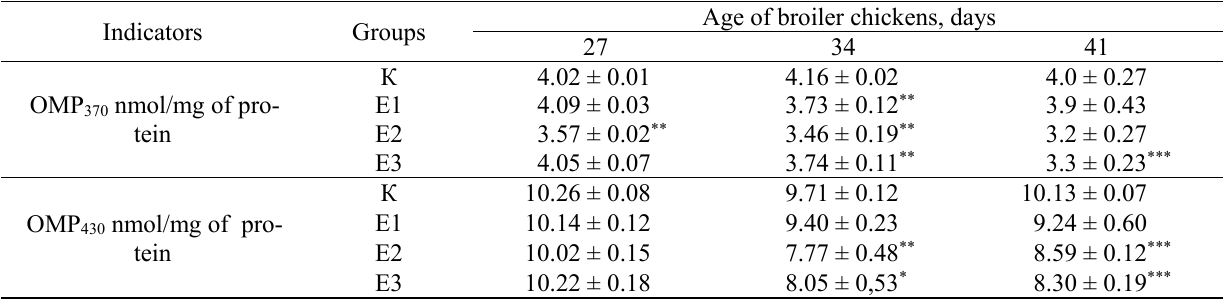
The content of aldehyde (OMP 370 ) and ketone (OMP 430 ) derivatives of oxidative protein modification in the blood of broiler chickens (M ± m; n =